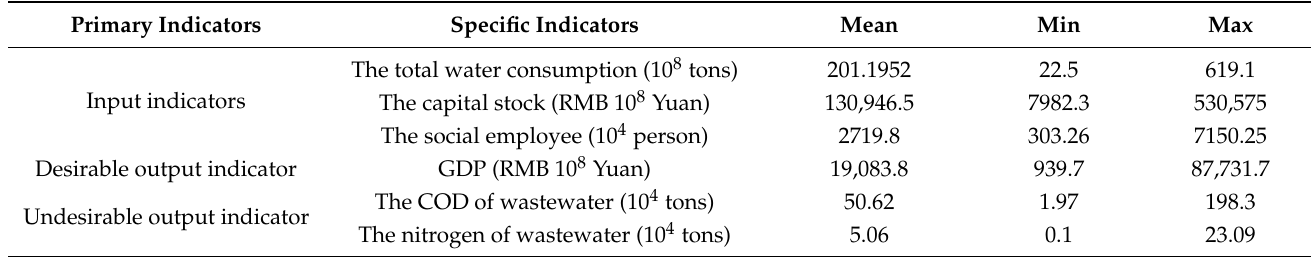
Figure 1. The schematic diagram of the four economic zones of China.